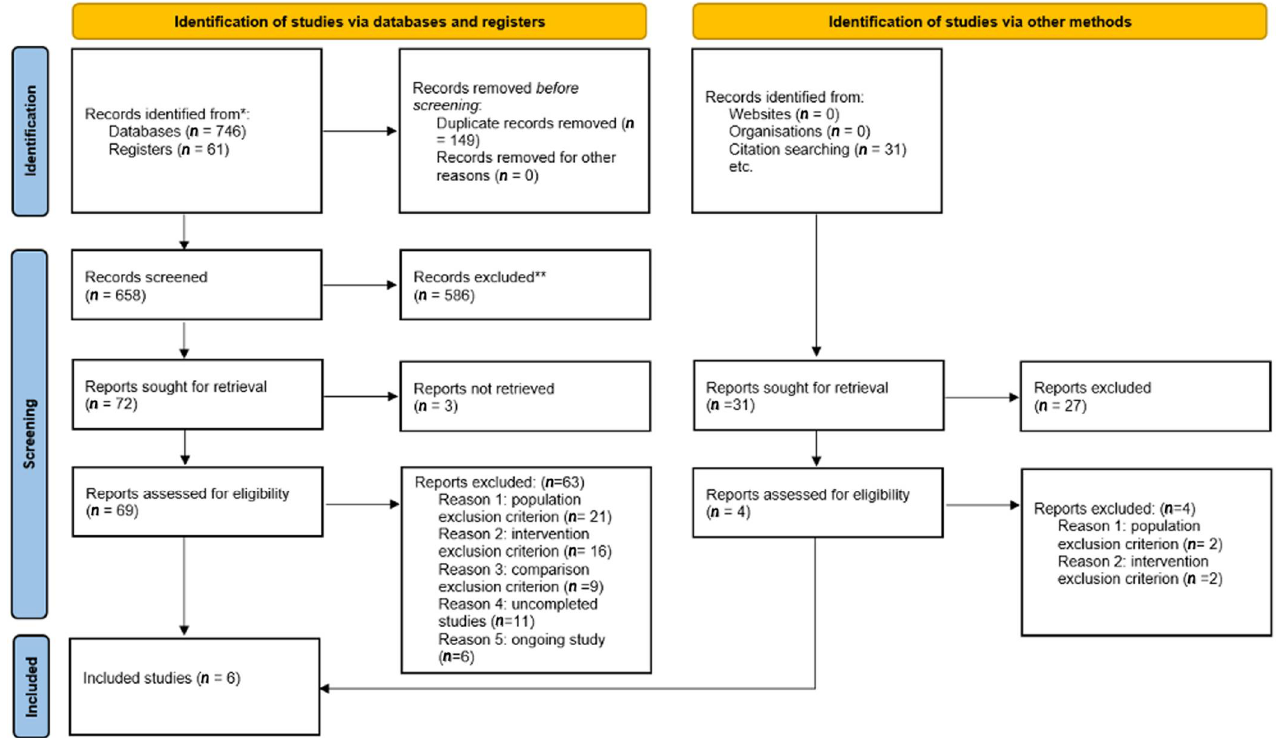
Figure 1. Study flow diagram.